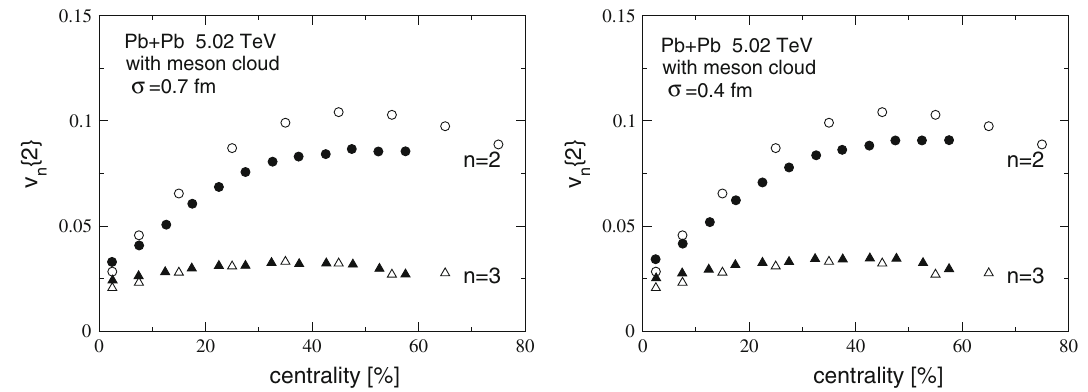
Fig. 7 Centrality dependence of v 2 { 2 } (filled circles) and v 3 { 2 } (filled the linear response approximation (see text for explanations) using the √ s = 5 . 02 TeV obtained from ε 2 , 3 triangles) for Pb + Pb collisions at results of the hydrodynamic simulations of Ref. [3]. Open circles and with meson cloud for σ = 0 . 7 (left) and 0 . 4 fm (right) with the help of triangles are v 2 , 3 { 2 } from ALICE [41]